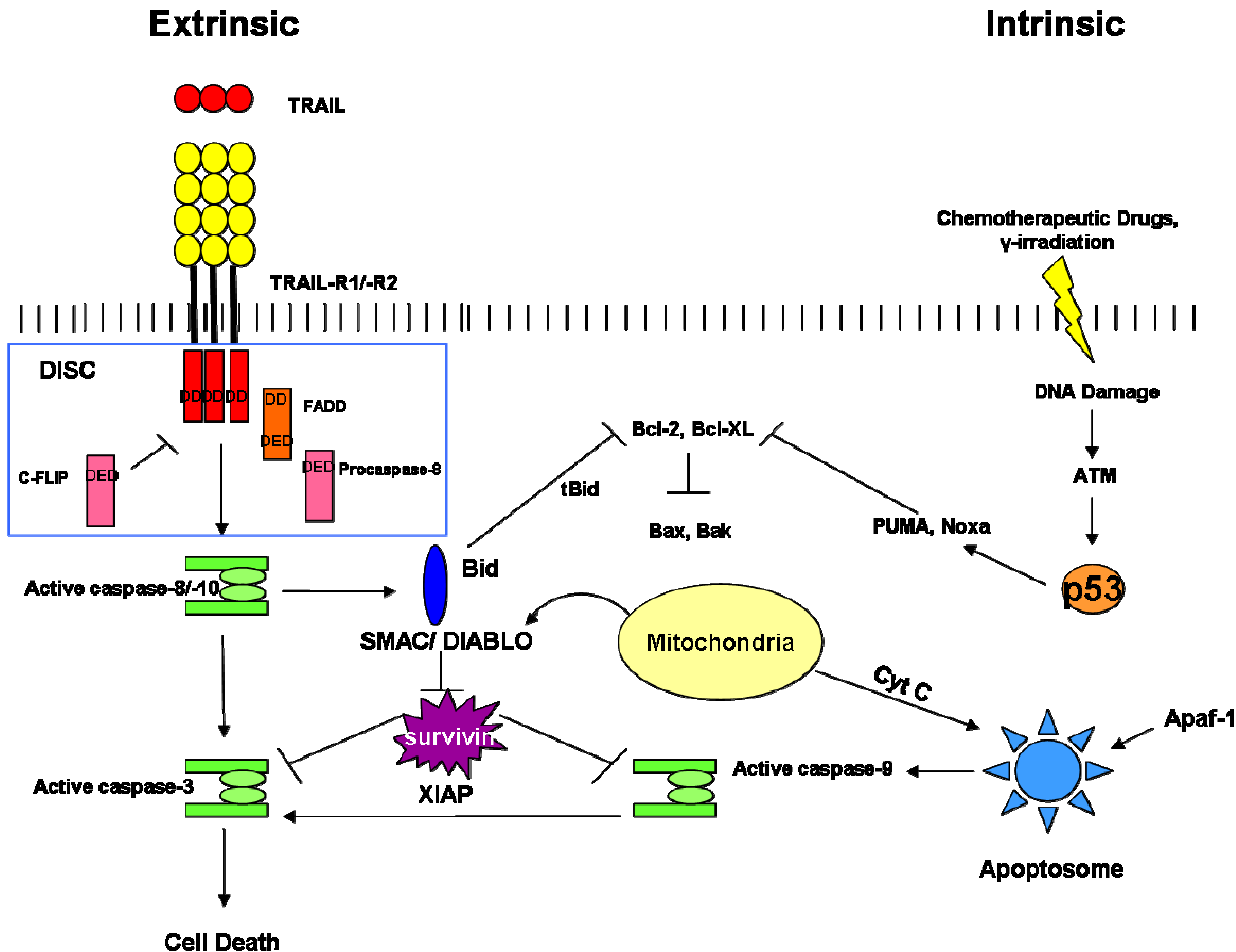
Figure 2. The two major processes that control